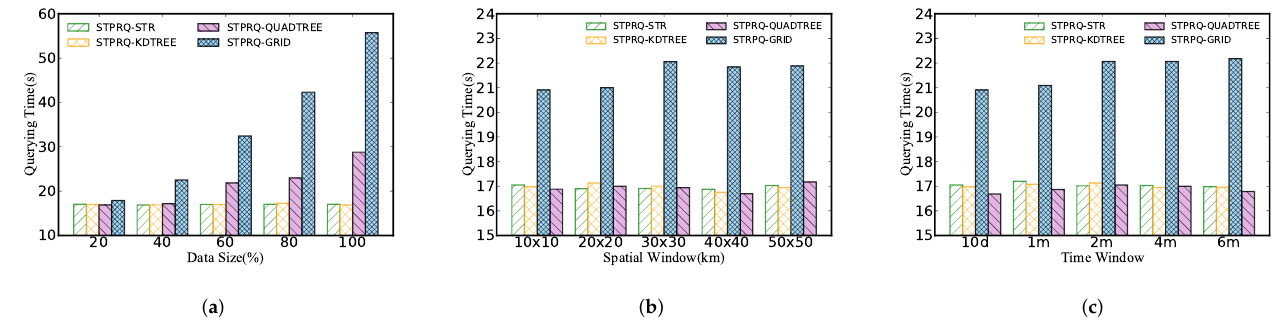
Figure 6. Performance of spatio-temporal polygon range query. ( a ) Data size. ( b ) Spatial window. ( c ) Time window.